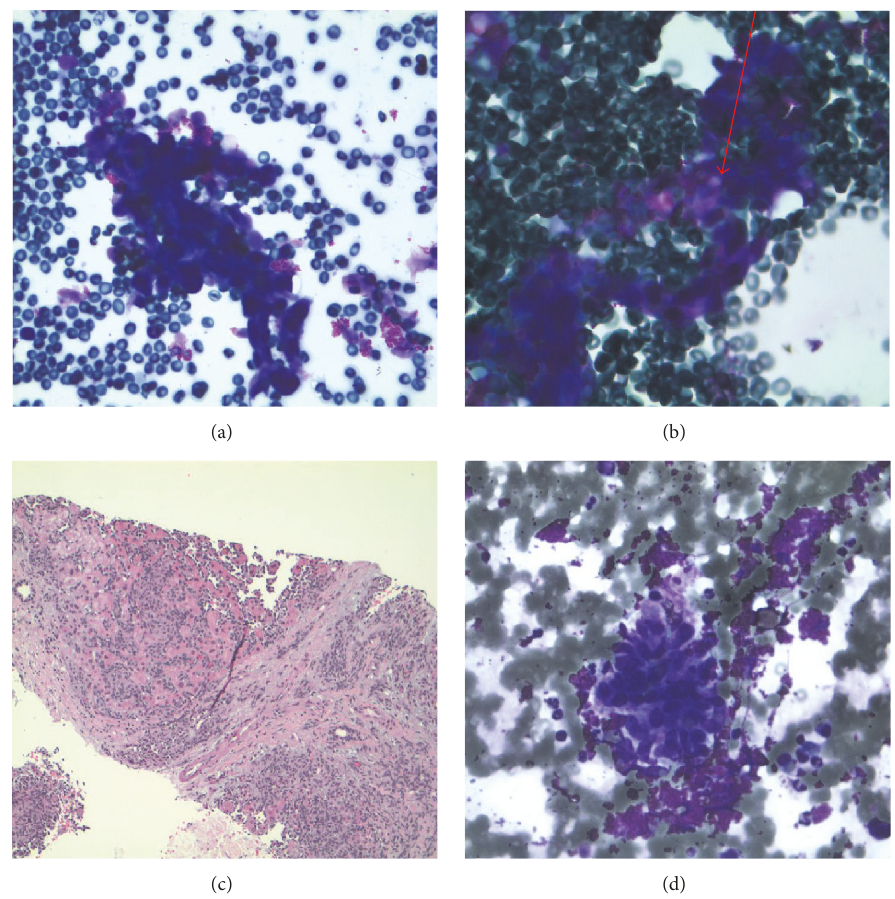
Figure 3: (a) 400x Romanowsky stain demonstrating epithelioid cluster delineating vasoformative features. (b) 630x Romanowsky stain demonstrating vessel and plump hyperchromatic nuclei and intracytoplasmic lumen (arrow). (c) 100x angiosarcoma H&E demonstrating tumor consisting of anastamosing vascular channels and hobnailing nuclei. (d) 400x Romanowsky stain demonstrating malignant spindle cellular